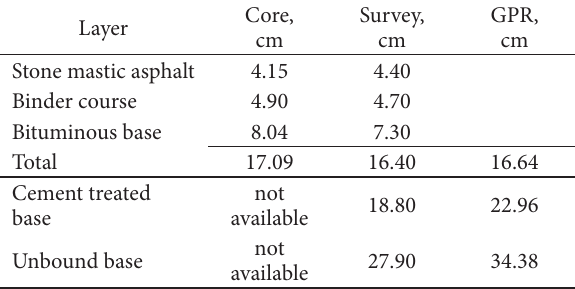
Fig. 6. Comparison to the thickness of unbound base layers on motorways Table 1. Layer thickness data at chainage 3.800